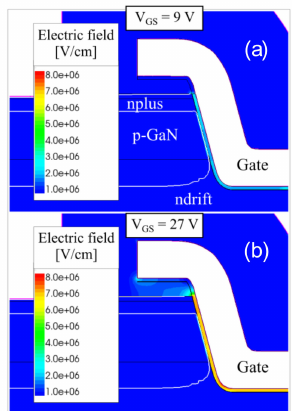
Figure 12. Simulations of the electric field under on-state V GS biasing on Wafer M and Wafer B structures: for the uni-layer device at V GS = 9 V and V DS = 1 V ( a ), for the bilayer device at V GS = 27 V and V DS = 1 V ( b ).